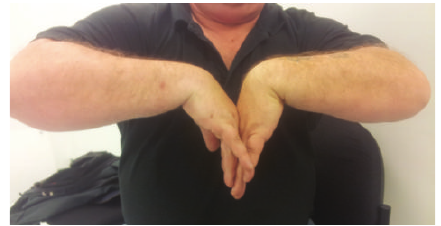
Figure 6: Postdistraction wrist flexion.